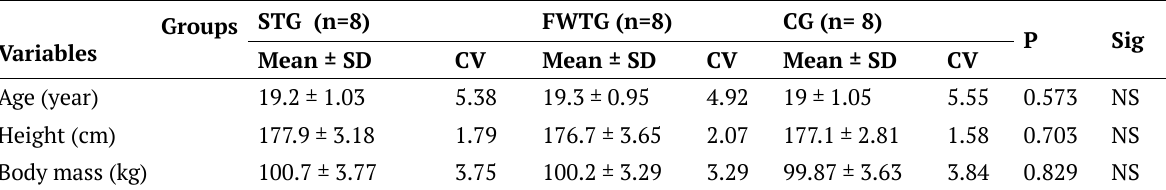
Table 1. Anthropometric data of subjects (mean±SD)) and p-value between